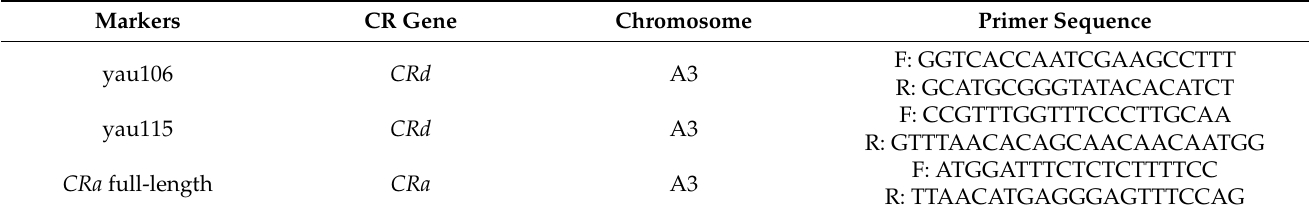
Figure 3. Screening results for polymorphic markers for foreground selection. ( A ) polymorphism of CRa full-length marker between CR252 and 85–74. ( B ) polymorphism of CRd linked markers yau106 and yau115 between CR252 and 85–74, respectively. Table 1. Molecular marker details for foreground selection of two CR